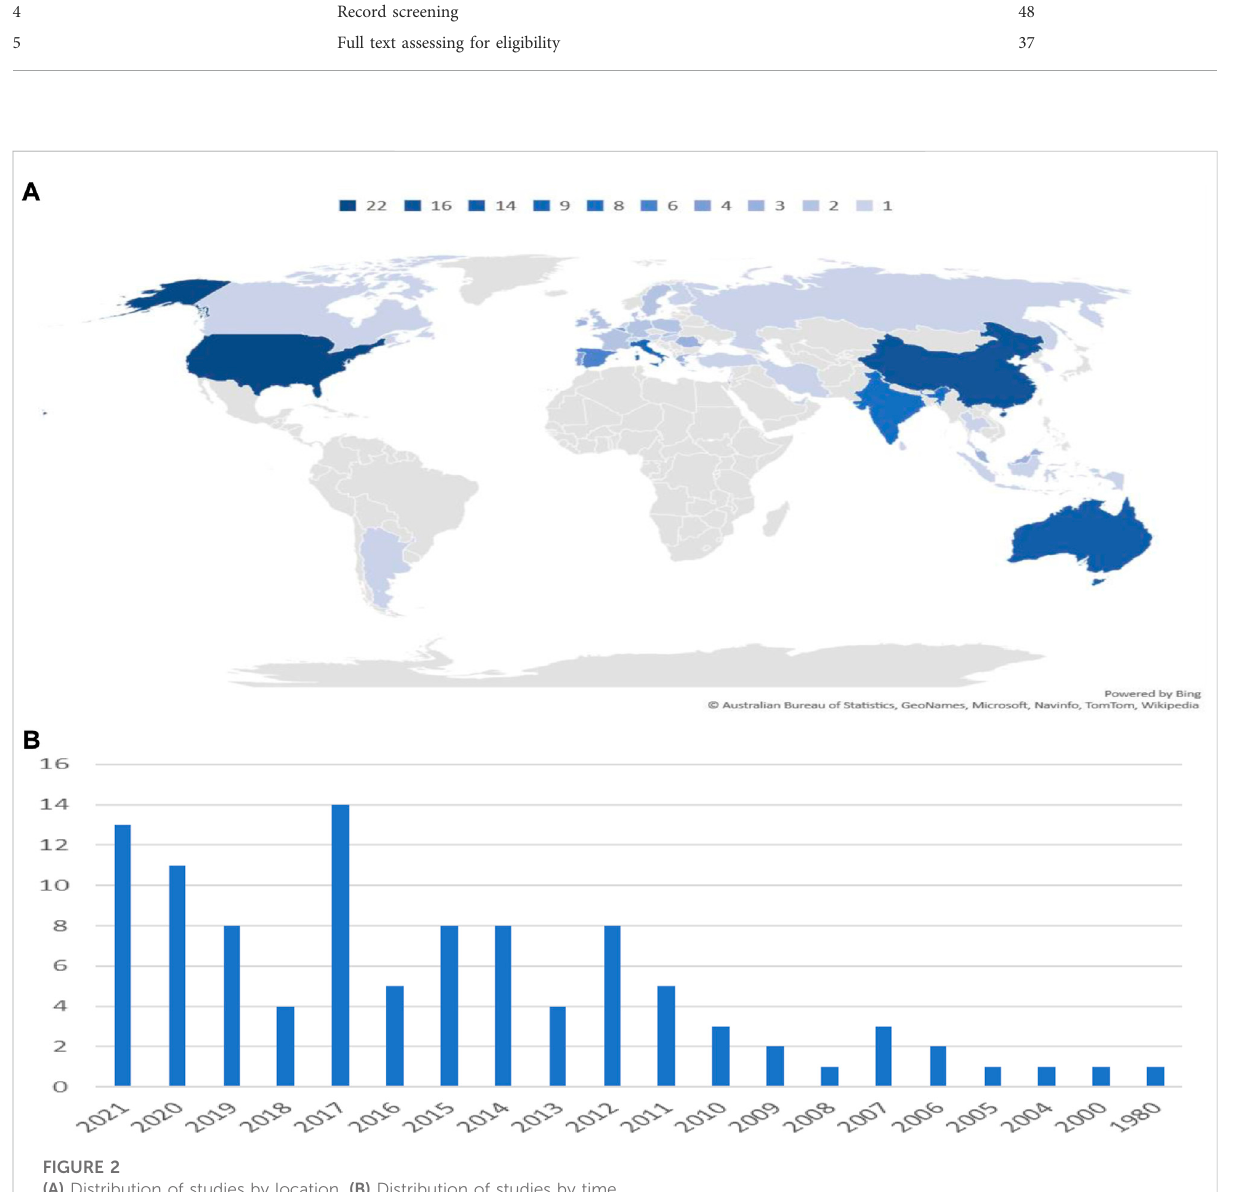
FIGURE 2 (A) Distribution of studies by location. (B) Distribution of studies by